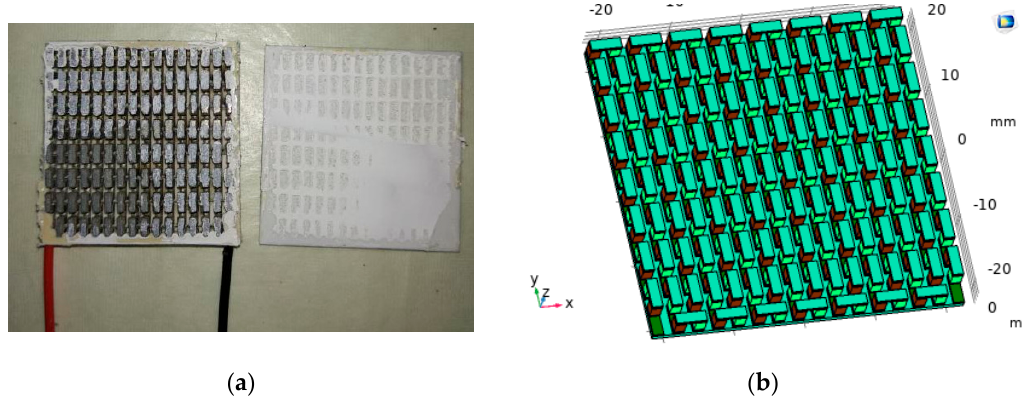
Figure 1. ( a ) Commercial thermoelectric plate; ( b ) COMSOL finite element model.